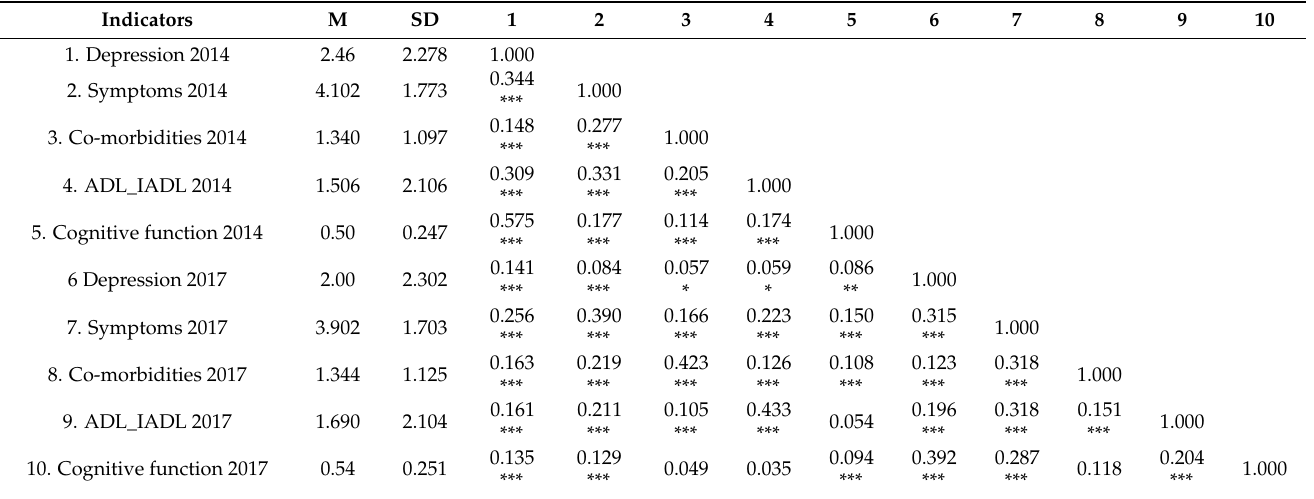
Table 2. Bivariate correlations between depressive symptoms and frailty among participants ( n = 1376).